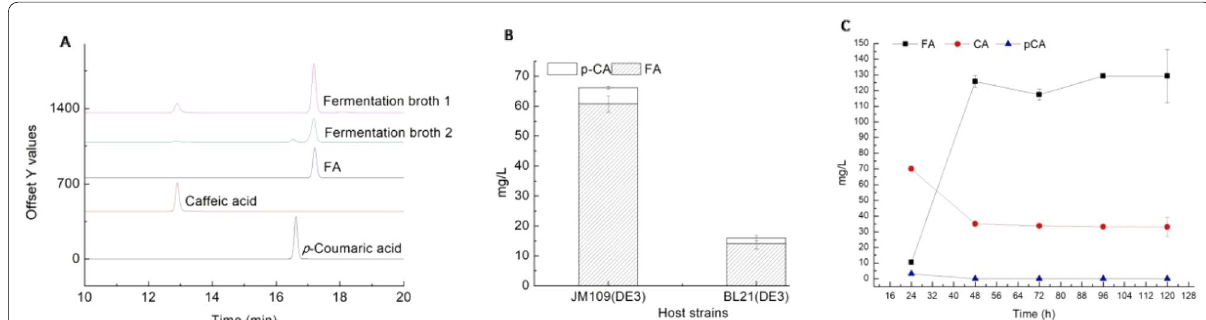
Fig.2 Heterologous biosynthesis of FA in E. coli. A HPLC profiles of the fermentation products and the FA, p -coumaric acid and caffeic acid standards. B FA production by strains based on E. coli JM109(DE3) and BL21(DE3) carrying the plasmid pBR322-T7-tal-sam5-comt. The fermentation was carried out in terrific broth (TB) medium with the addition of 1 g/L L -tyrosine and 2% (v/v) glycerol at 28 °C and 250 rpm for 3 days. p-CA p -coumaric acid; FA trans -ferulic acid. C Time course of FA production from L -tyrosine by E . coli JM109(DE3) T5FA in M9Y medium supplemented with 2% (v/v) glycerol and 1 g/L L -tyrosine at 28 °C and 250 rpm for 5 days